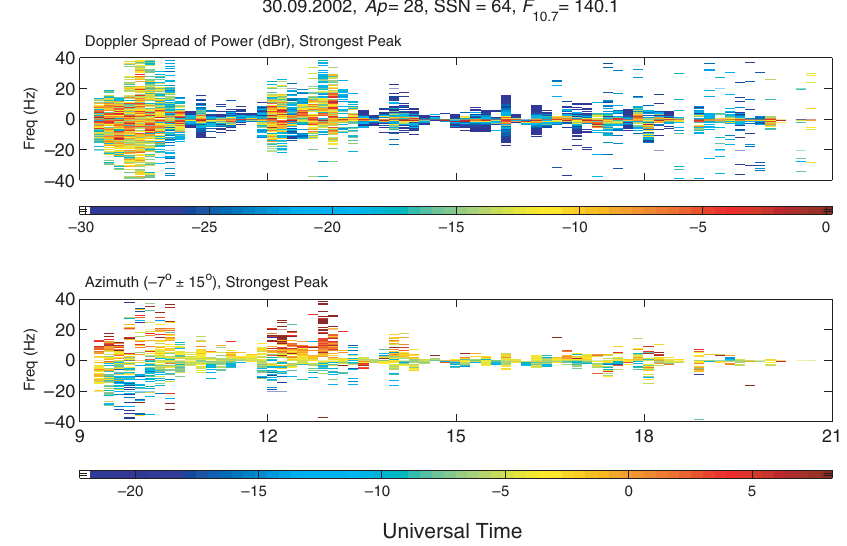
Fig. 14.9. Doppler spectrum ( upper panel) and direction of arrival ( lower frame) for the 11 MHz signal re- ceived over the Svalbard to Kiruna path (30th September